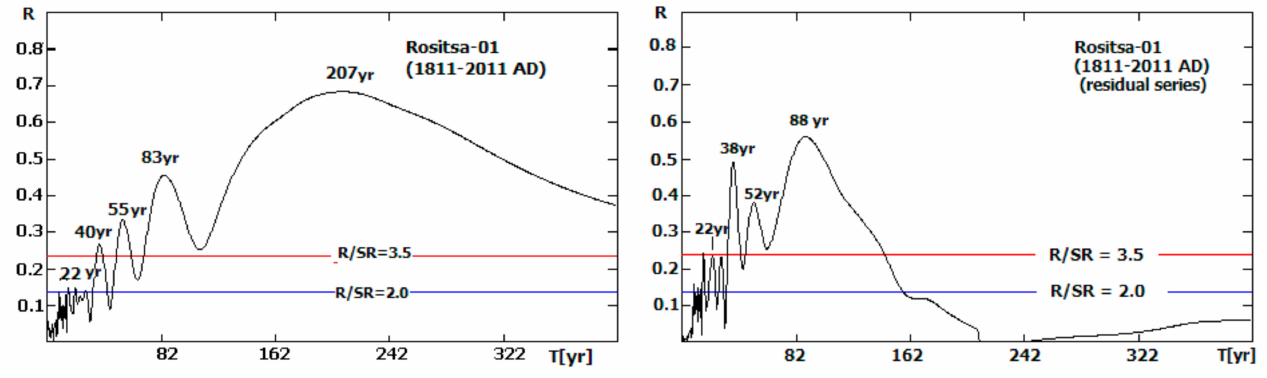
Figure 5. Left : The “Rositsa-01” T – R correlogram (original series); right : The T – R correlogram of “residual” series, after demodulation of the 207 year